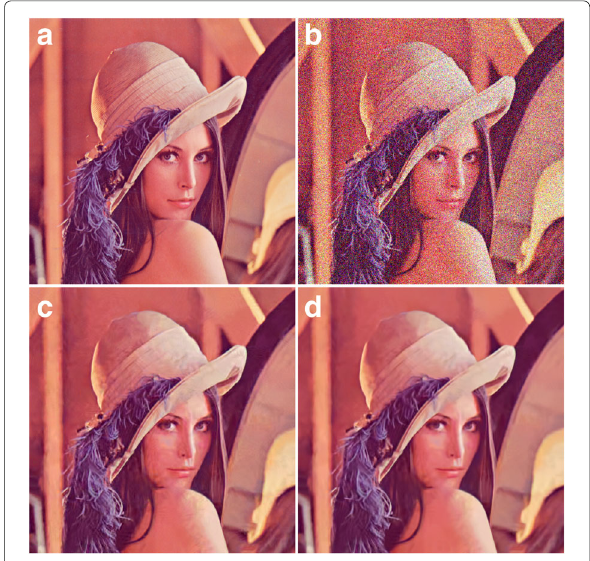
Fig. 6 Subjective assessment between the color normal profile of BM3D and the proposed method. a Original image. b Noisy image at noise level σ = 50, PSNR = 14.81, and SSIM = 0.5495. c Output using the normal profile of BM3D, PSNR = 29.55 and SSIM = 0.9741. d Output using the proposed method, PSNR = 29.89 and SSIM =